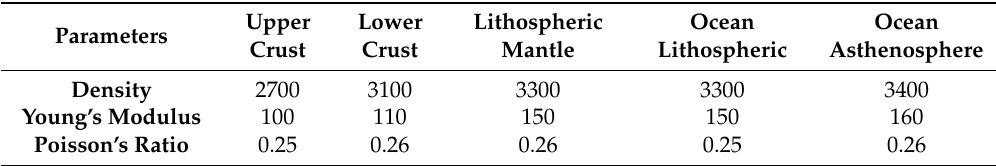
Figure 5. FE results. ( a ) Geological cross-section, modified from [18]. Black segment is the segment of the slab along which the loading is applied to simulate the earthquake thrusting. ( b ) Contour line of the retrieved slip model, superimposed on the discretized domains. ( c ) Comparison between the DInSAR vertical component and model. ( d ) Comparison between the DInSAR EW component and model. Table 2. Parameters for each layer defined in the model: Density (kg/m 3 ), Young’s Modulus (GPa) and Poisson Ratio. Modified from [7,21].